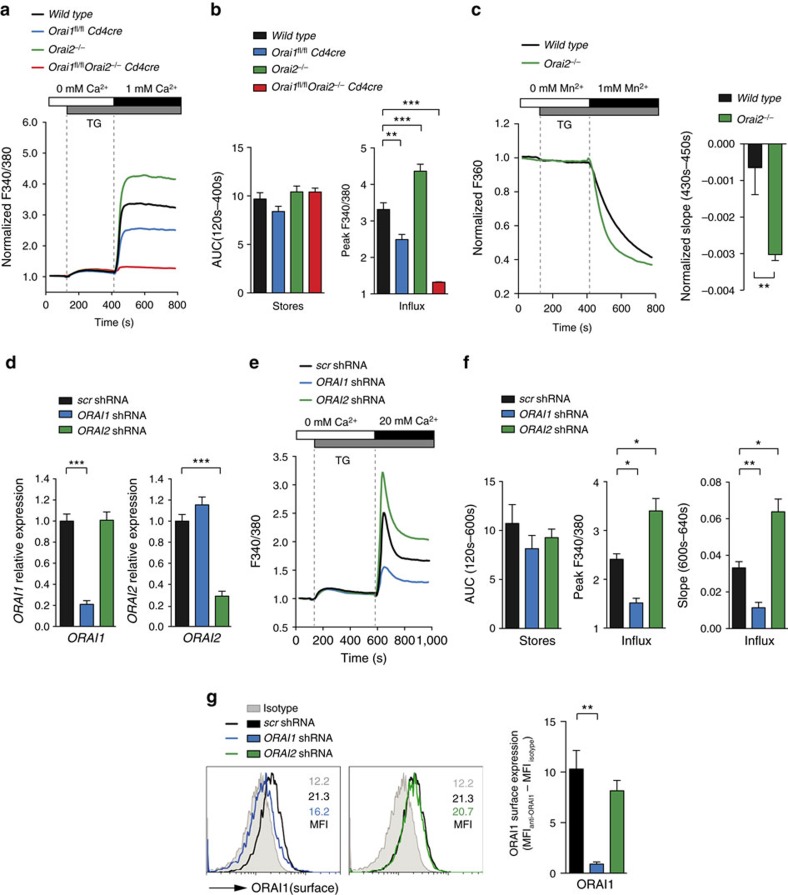
Orai2-deficient cells have increased SOCE.(a,b) Analysis of Ca2+ store depletion and SOCE following thapsigargin (TG) stimulation in naive T cells from WT, Orai1-deficient (Orai1fl/flCd4cre), Orai2-deficient (Orai2−/−) and Orai1/Orai2-deficient (Orai1fl/flOrai2−/−Cd4cre) mice using a FlexStation plate reader. (b) Quantification of store depletion (area under the curve, AUC120 s–400 s) and SOCE (peak F340/380) as shown in a; means±s.e.m. of seven to nine mice. (c) Indirect measurement of SOCE by Mn2+ quenching of Fura-2 fluorescence. WT and Orai2-deficient naive T cells were stimulated with TG in Ca2+-free Ringer solution followed by the addition of 1 mM Mn2+-containing Ringer solution. Quantification of the slope of Mn2+ quenching in TG-stimulated T cells normalized to quenching in non-stimulated cells; means±s.e.m. of three mice. (d–g) Increased SOCE in human fibroblasts after shRNA-mediated knockdown of ORAI2 is not due to ORAI1 upregulation. (d) Analysis of knockdown efficiency of ORAI1 and ORAI2 in human fibroblast cells after transduction with shRNAs against ORAI1 and ORAI2 by qRT–PCR; means±s.e.m. of four experiments. (e) Analysis of Ca2+ store depletion and SOCE following TG stimulation in shORAI1- or shORAI2-treated human fibroblast cells using a FlexStation plate reader. (f) Quantification of store depletion (AUC120 s–600 s) and SOCE (F340/380 peak and F340/380 slope600 s–640 s) in human fibroblast cells as shown in e; means±s.e.m. of four experiments. (g) Analysis of ORAI1 surface expression in human fibroblast cells following shRNA-mediated knockdown of ORAI1 and ORAI2 as described in (d) by flow cytometry using an anti-ORAI1 monoclonal antibody (29A2) recognizing the second extracellular domain of ORAI1; means±s.e.m. of three experiments. *P<0.05; **P<0.005; ***P<0.001 in (b–d,f,g) using unpaired Student's t-tests.